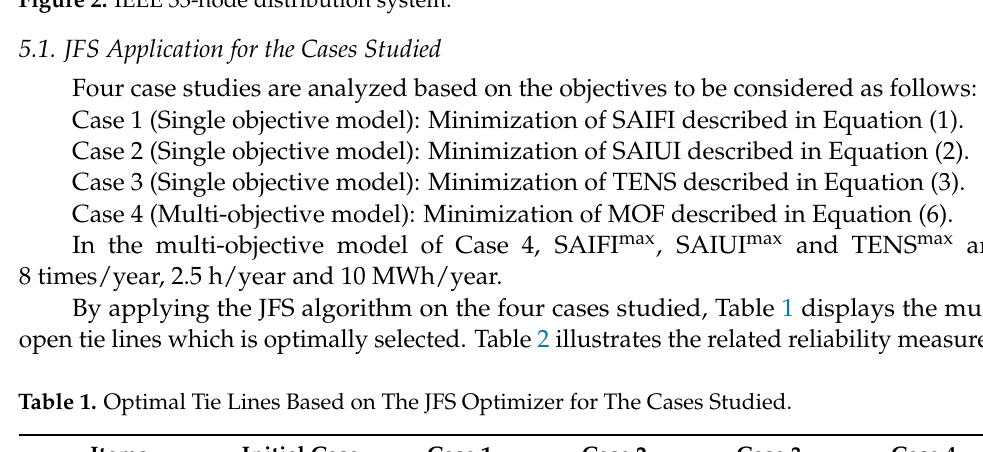
Figure 2. IEEE 33-node distribution system.